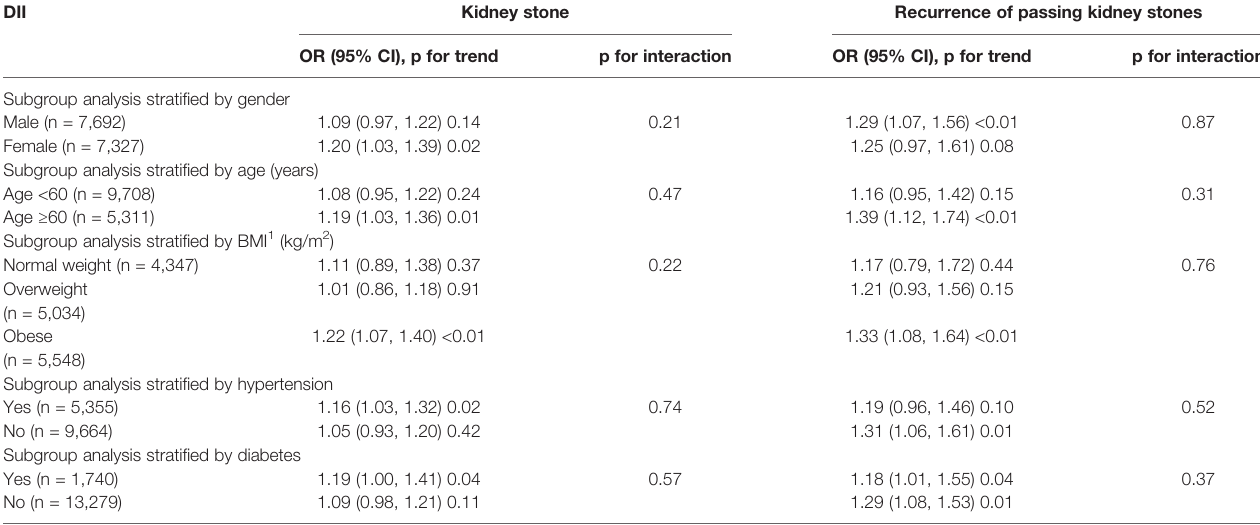
TABLE 3 | Subgroup analysis. DII Kidney stone Recurrence of passing kidney stones OR (95% CI), p for trend p for interaction OR (95% CI), p for trend p for